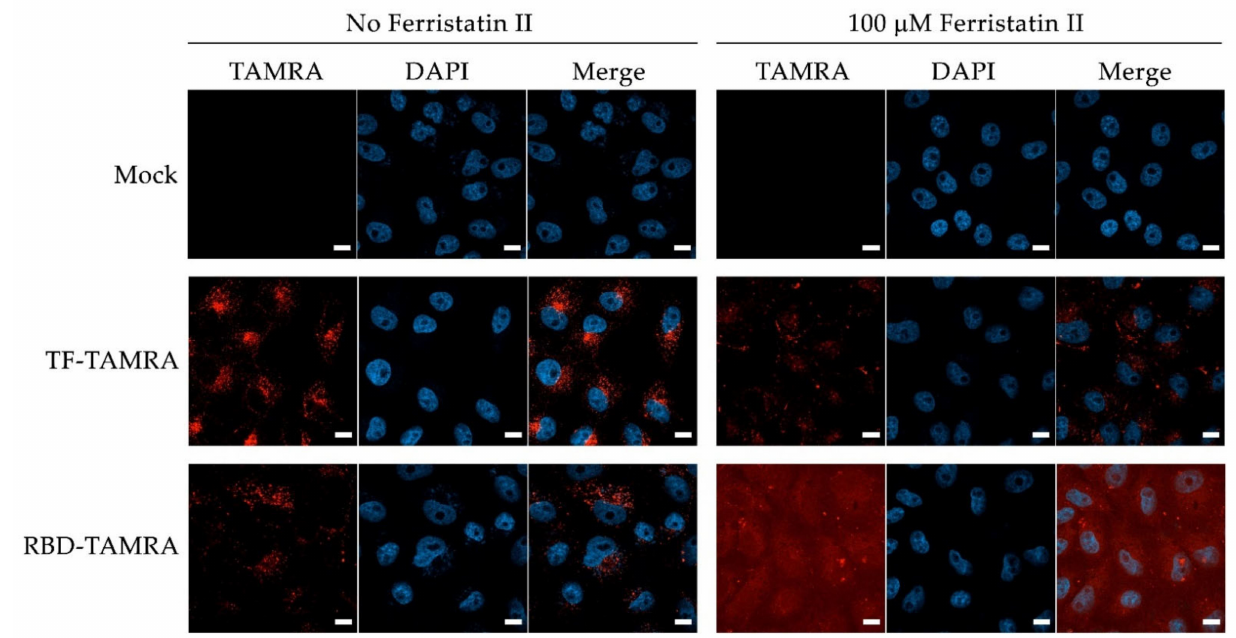
Figure 5. Confocal images showing Fe 2 -TF and RBD binding and uptake to Vero cells without treatment (Mock) and with treatmentfor 18 h by 100 µ M Ferristatin II. TAMRA-labeled Fe 2 -TF and RBD (1.2 µ M) were added to cells for 1.5 h. Nuclei were stained by DAPI. Scale bar: 10 µ m. The micrographs shown are representative of three separate experiments, fixation and details of microscopy, are described in Materials and